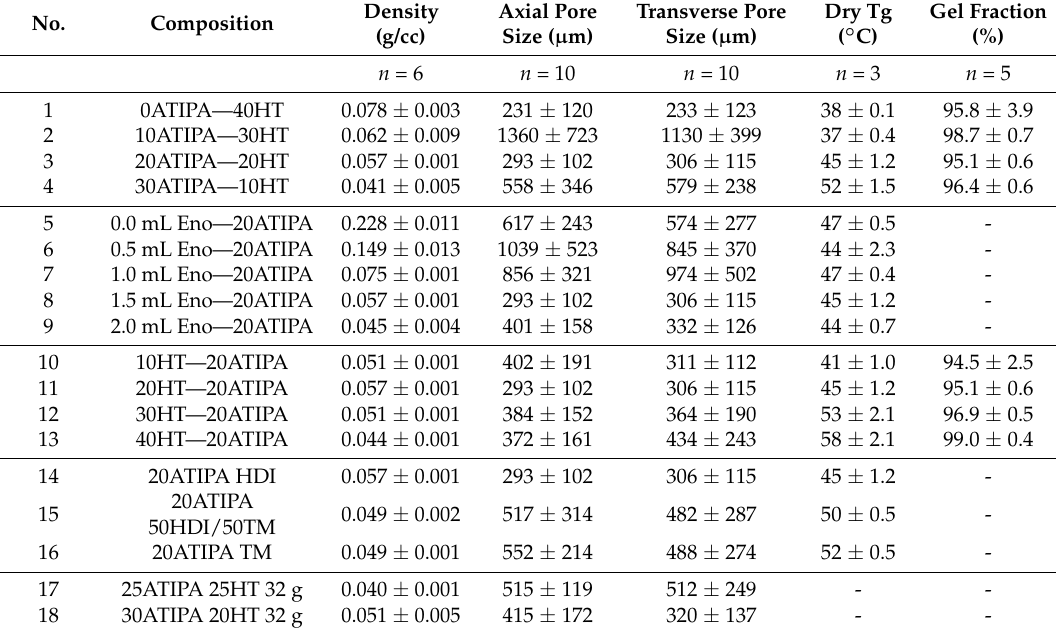
Table 2. Physical and thermomechanical ATIPA foam